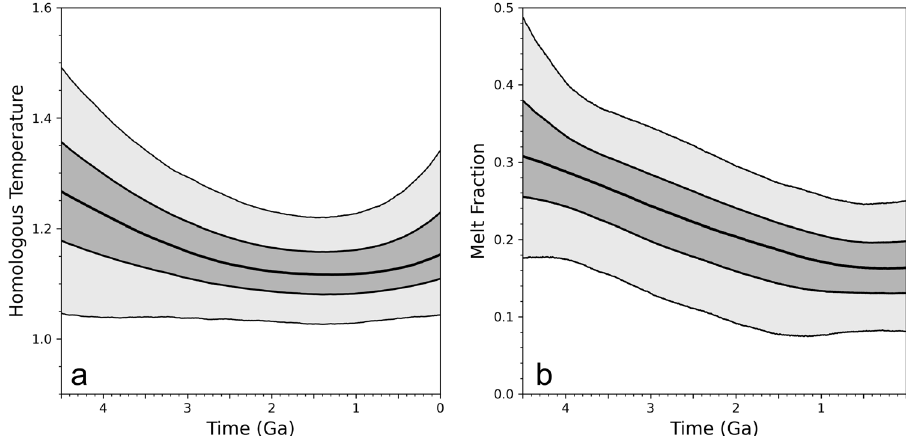
Fig. 5 Measures of melt co-regulation due to changes in viscous self-regulation. a Inversion results for the homologous temperature ( T H ), the ratio of the geotherm and wet solidus at the base of the lithosphere ( b ) Inversion results for melt fraction showing a decline for billions of years followed by a leveling off near present day. Each of the fi gures show results as distributions about their median value. The darker color highlights values falling between the upper and lower quartiles and the lighter color constraining the maximal and minimal